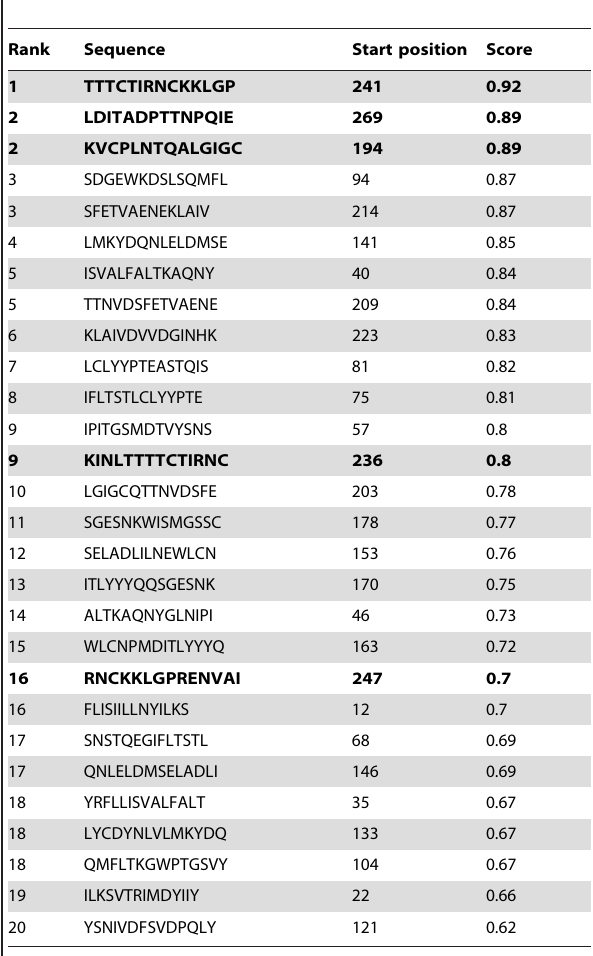
Table 3. Tabulated from of results derived from ABCpred